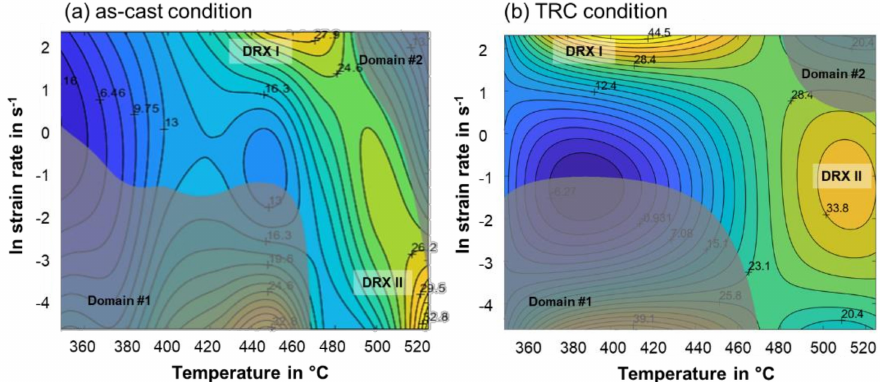
Figure 13. Processing maps of the ( a ) as-cast condition and ( b ) TRC condition in the temperature range from 350 ◦ C to 525 ◦ C at a strain of 0.4